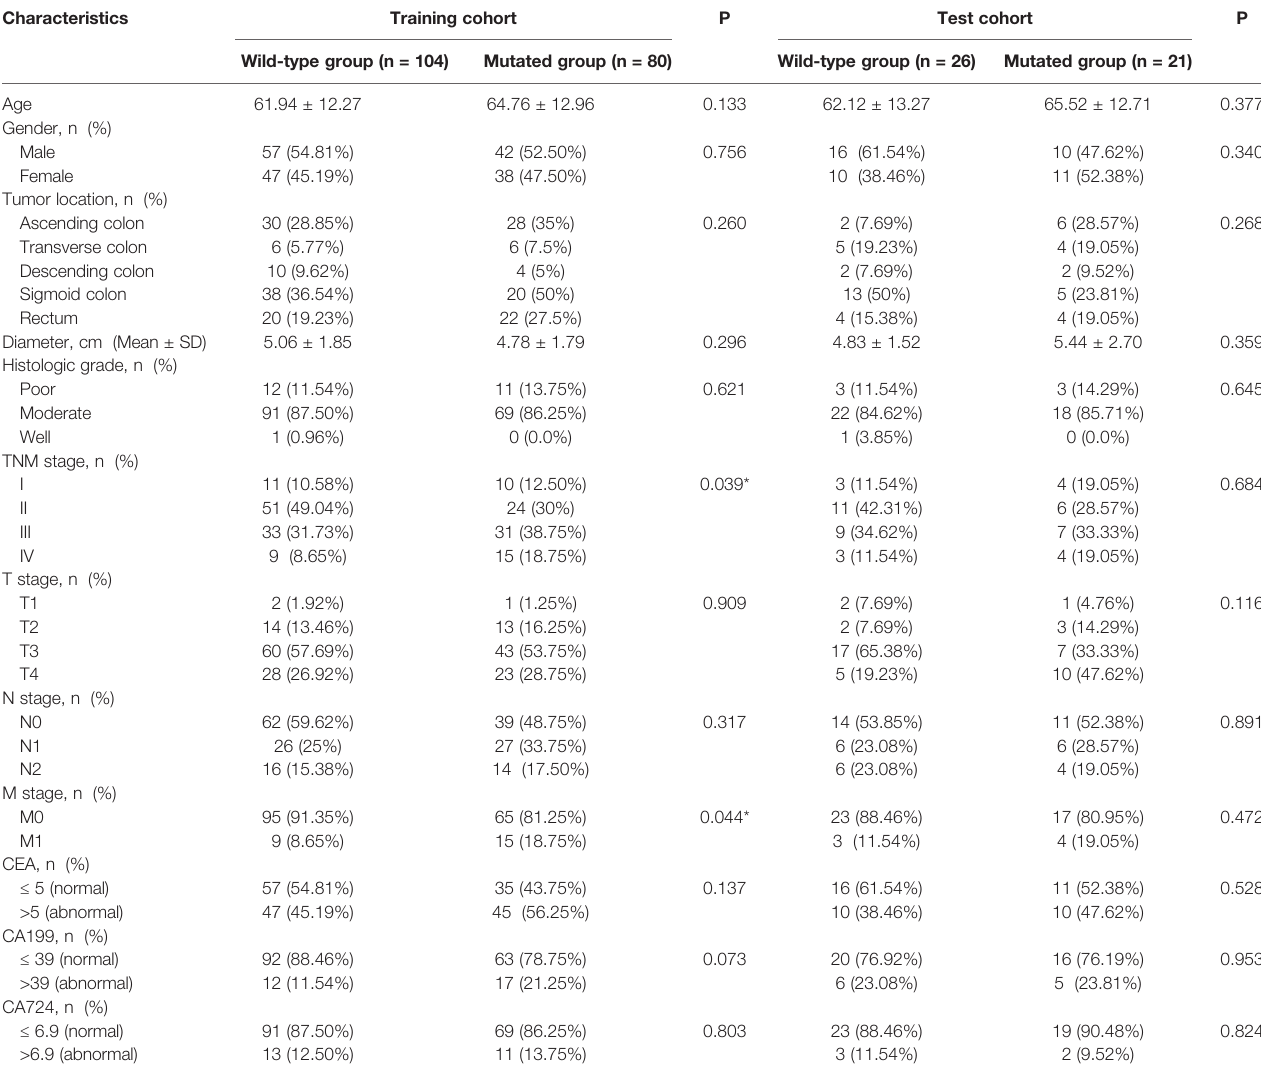
TABLE 1 | Patient and tumor characteristics in the training and test cohort. Characteristics